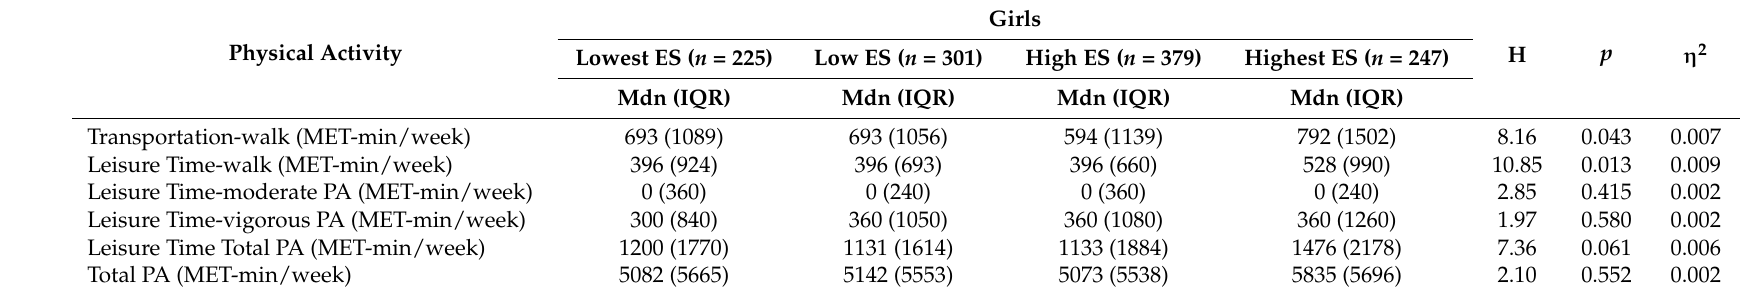
Table 3. Weekly physical activity in girls ( n = 1152) by different levels of perceived neighborhood environment safety